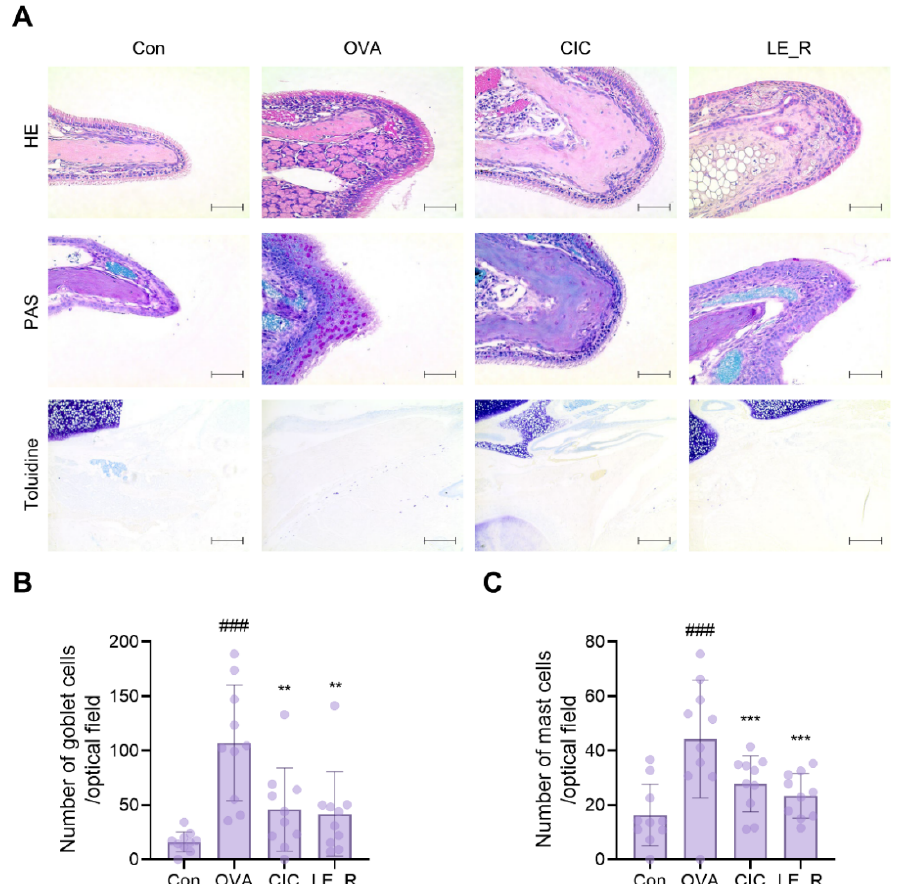
Figure 5. The L. erythrorhizon reflux ethanol extract causes histological changes in the nasal tissues of mice with OVA-induced allergic rhinitis. ( A ) Hematoxylin and eosin (HE), Periodic Acid-Schiff (PAS), and toluidine blue staining of nasal tissue samples from each group (scale bars, 400 µ m). Quantification of staining in histological sections enables counting of ( B ) goblet cells (PAS staining) and ( C ) mast cells (toluidine blue staining). Data are expressed as the mean ± SD ( n = 10 per group). Significant differences at ### p < 0.001 versus the Control group; ** p < 0.01, *** p < 0.001 versus the ovalbumin group. Con, control; OVA, ovalbumin; CIC, ciclesonide; LE_R, reflux ethanol extract of L. erythrorhizon .